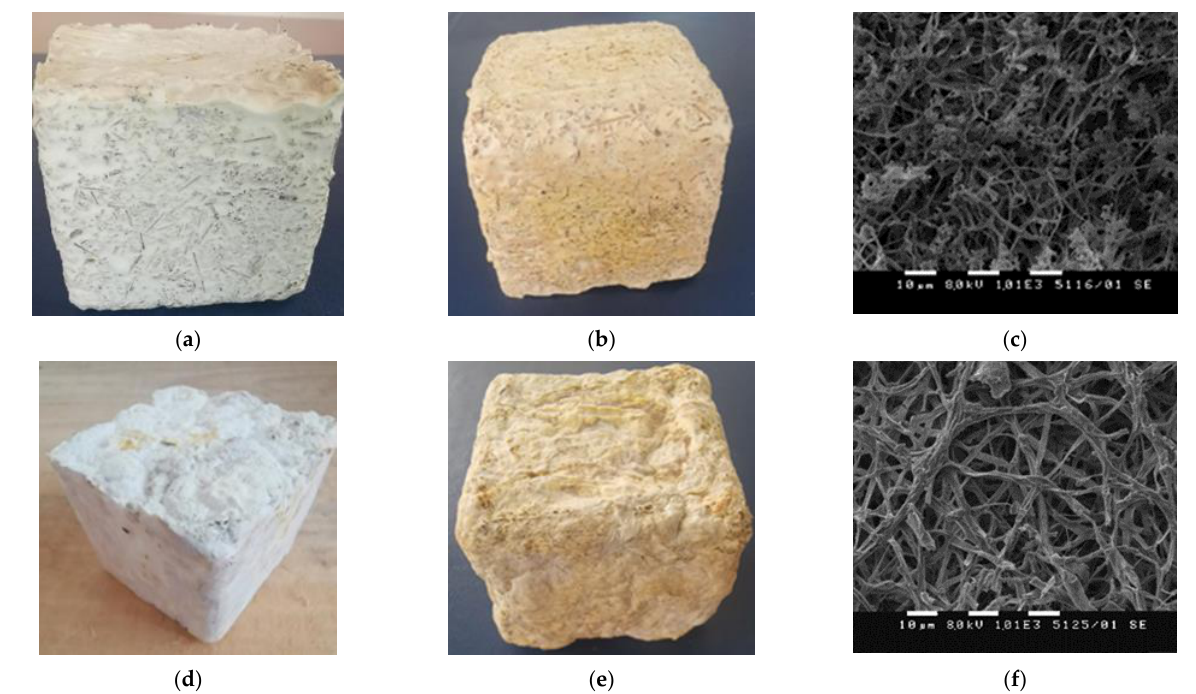
Figure 4. Mycelium steam distilled lavender straw (SDLS) - based bio - composites grown for 20 days before ( a ) and after drying at 60 °C for 8 h ( b ), Scanning Electron Microscopy (SEM) image of mycelium surface layer ( c ); mycelium hexane extracted rose flowers (HERF) - based bio - composites grown for 20 days before ( d ) and after drying at 60 °C for 8 h ( e ), SEM image of mycelium surface layer ( f ) .